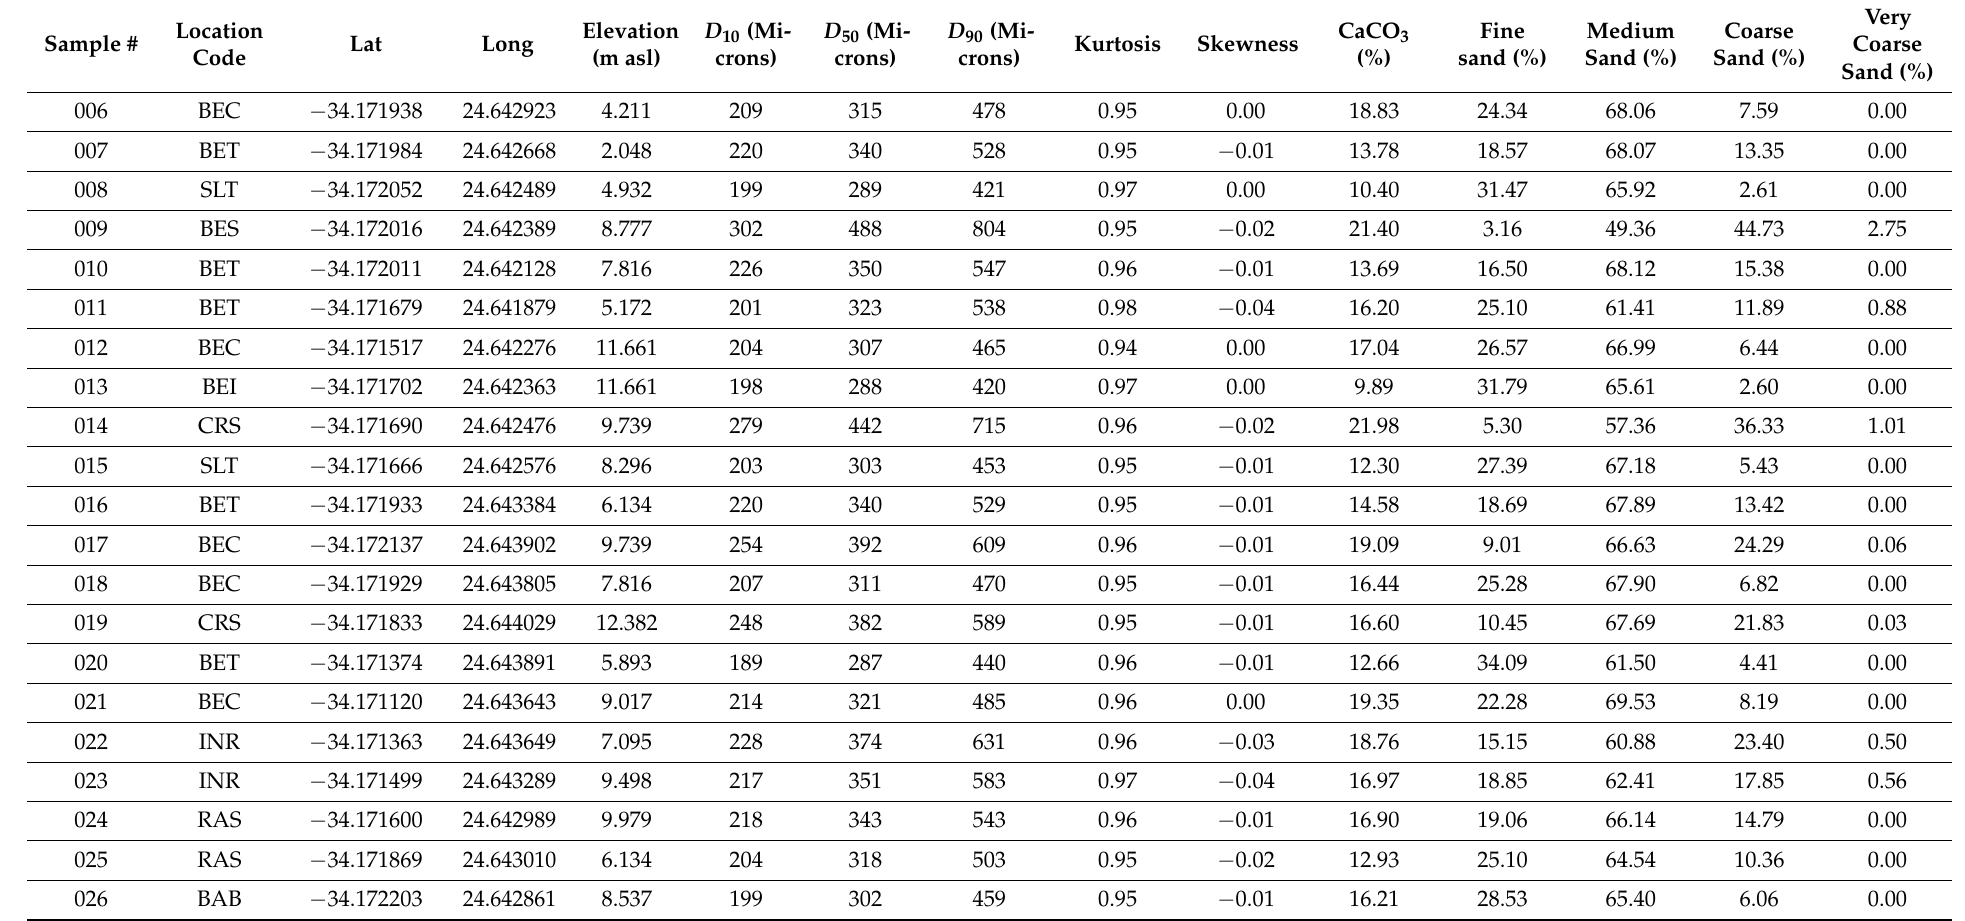
Table 1. Details of sediment samples examined in this study. Sample location codes are: BAB: Backshore, beach; BAC: Backshore, crest; BAI: Backshore, interdune; BAR: Backshore, ridge; BAS: Backshore, slipface; BAT: Backshore, trough; BEC: Beach, crest; BEI: Beach, interdune; BER: Beach, ridge; BES: Beach, slipface; BET: Beach, trough; CRI: Crest, interdune; CRR: Crest, ridge; CRS: Crest, slipface; CRT: Crest, trough; INT: Interdune, ridge; INS: Interdune, slipface; INT: